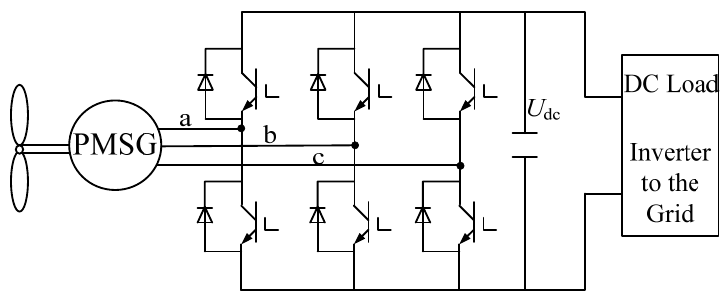
Figure 1. Configuration of a direct-drive PMSG